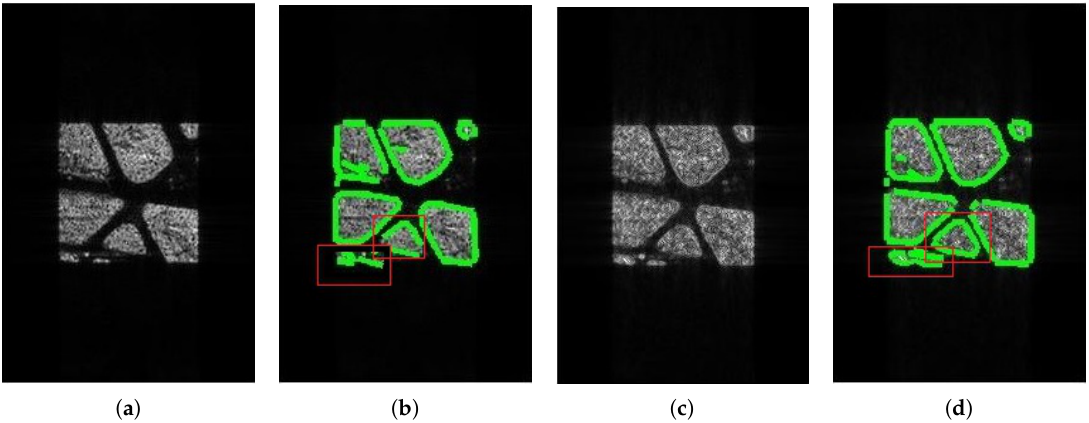
Figure 8. The imaging and edge detection result of complex area1. ( a ) Original image; ( b ) edge detection result of the original image; ( c ) edge-enhanced SAR image; ( d ) edge detection result of the edge-enhanced SAR image.